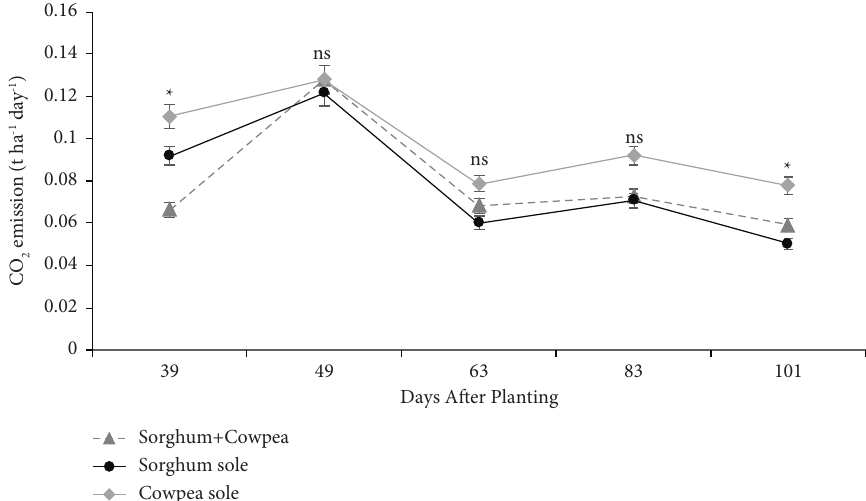
Figure 12: CO 2 emission rates of sorghum intercropped with cowpea, sorghum in sole and cowpea in sole cultures collected at Ofcolaco during the 2020/21 cropping season. ns � not signifcant; ∗ � signifcant at p ≤